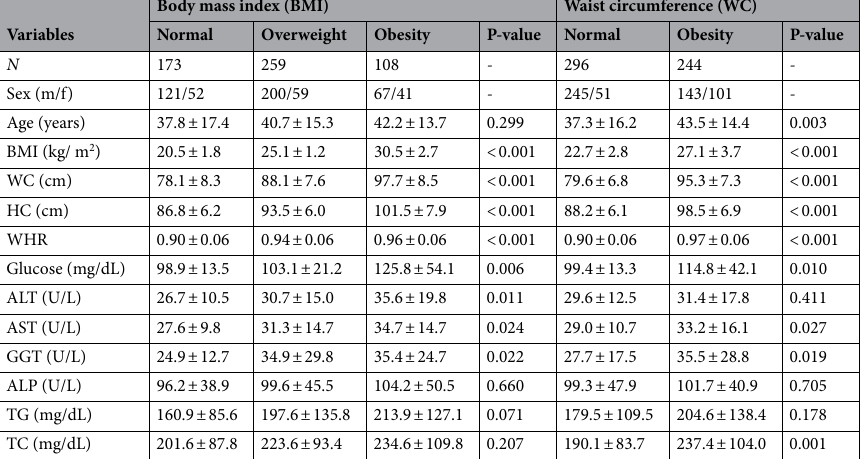
Table 2. Baseline characteristics of study participants in the BMI and WC groups. Data are presented as mean ± standard deviation (SD). P-values are obtained from the independent sample t-test in the WC groups and one-way ANOVA in the BMI groups.